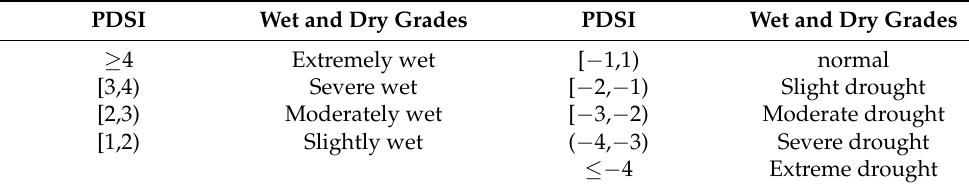
Table 1. Classification of wet and dry